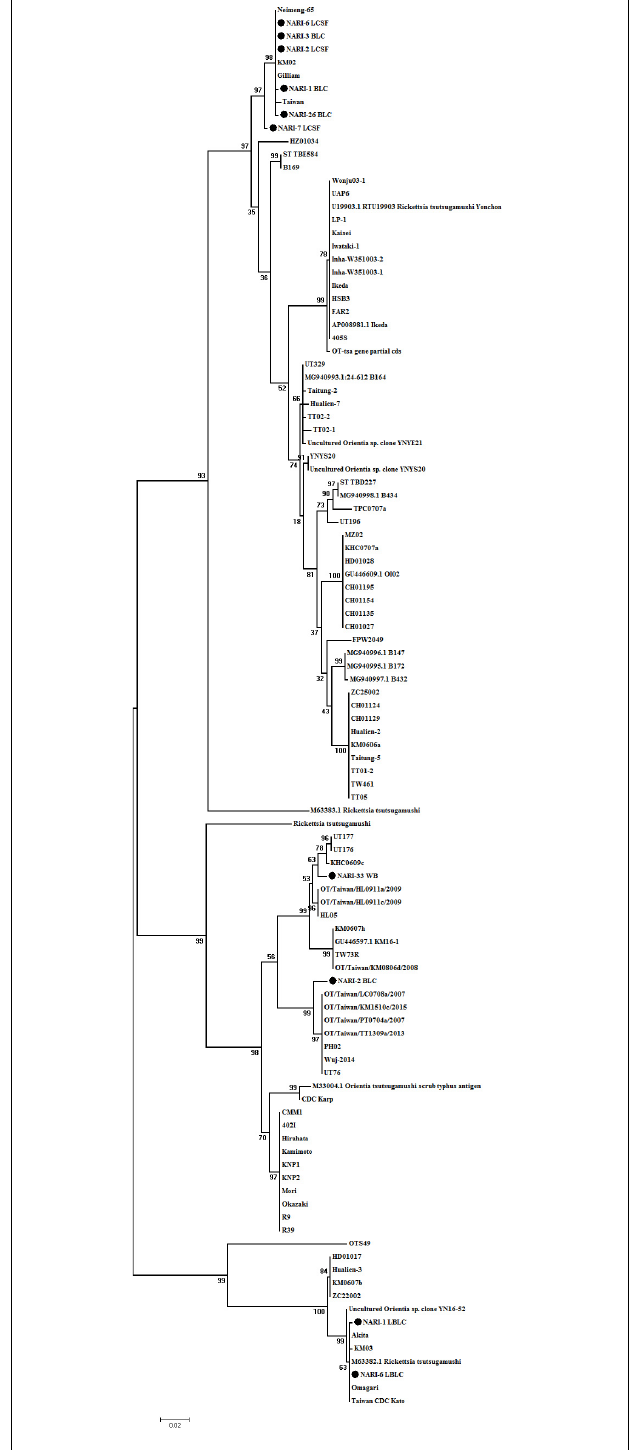
FIGURE 1 | Phylogenetic tree of O. tsutsugamushi strains constructed based on base-sequence homologies of 56 kDa type-specific genes. The numbers at nodes indicate bootstrap values. Bar shows genetic distance of 0.02. The isolates of from the study are submitted to GenBank under accession